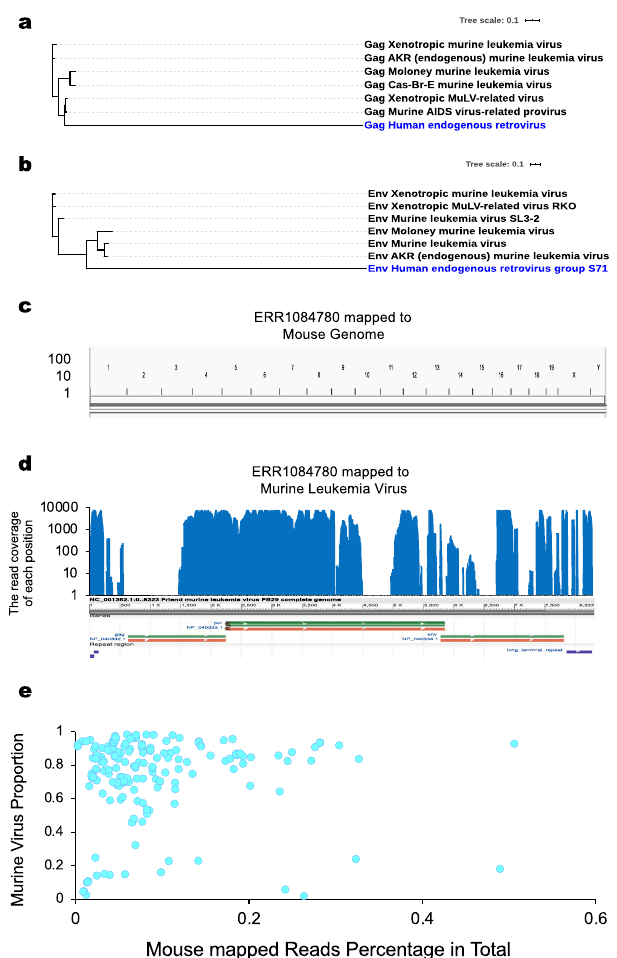
Fig. 2 Murine viral sequences from PDX are not from human viruses or correlated with mouse tissue contamination. a Phylogenetic analysis of GAG genes of murine (black) and human viruses (blue). b same analysis performed for ENV genes. c Low level of reads from PDX that can be mapped to mouse reference genome. d High-level murine virus reads mapped to the MLV viral genome. e No signi fi cant correlations were found between the number of mouse-speci fi c ( x -axis) and murine viruses reads ( y -axis) across all PDX samples examined ( n = 184). Source data for e are provided in Source Data